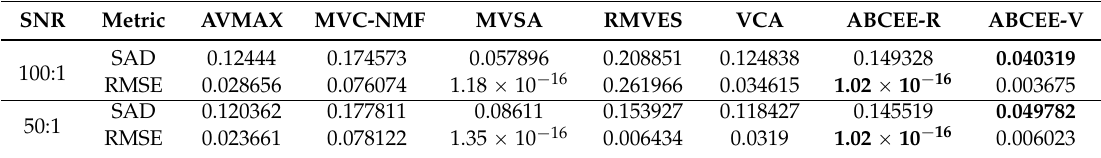
Table 3. Experimental results for synthetic hyperspectral dataset 3.